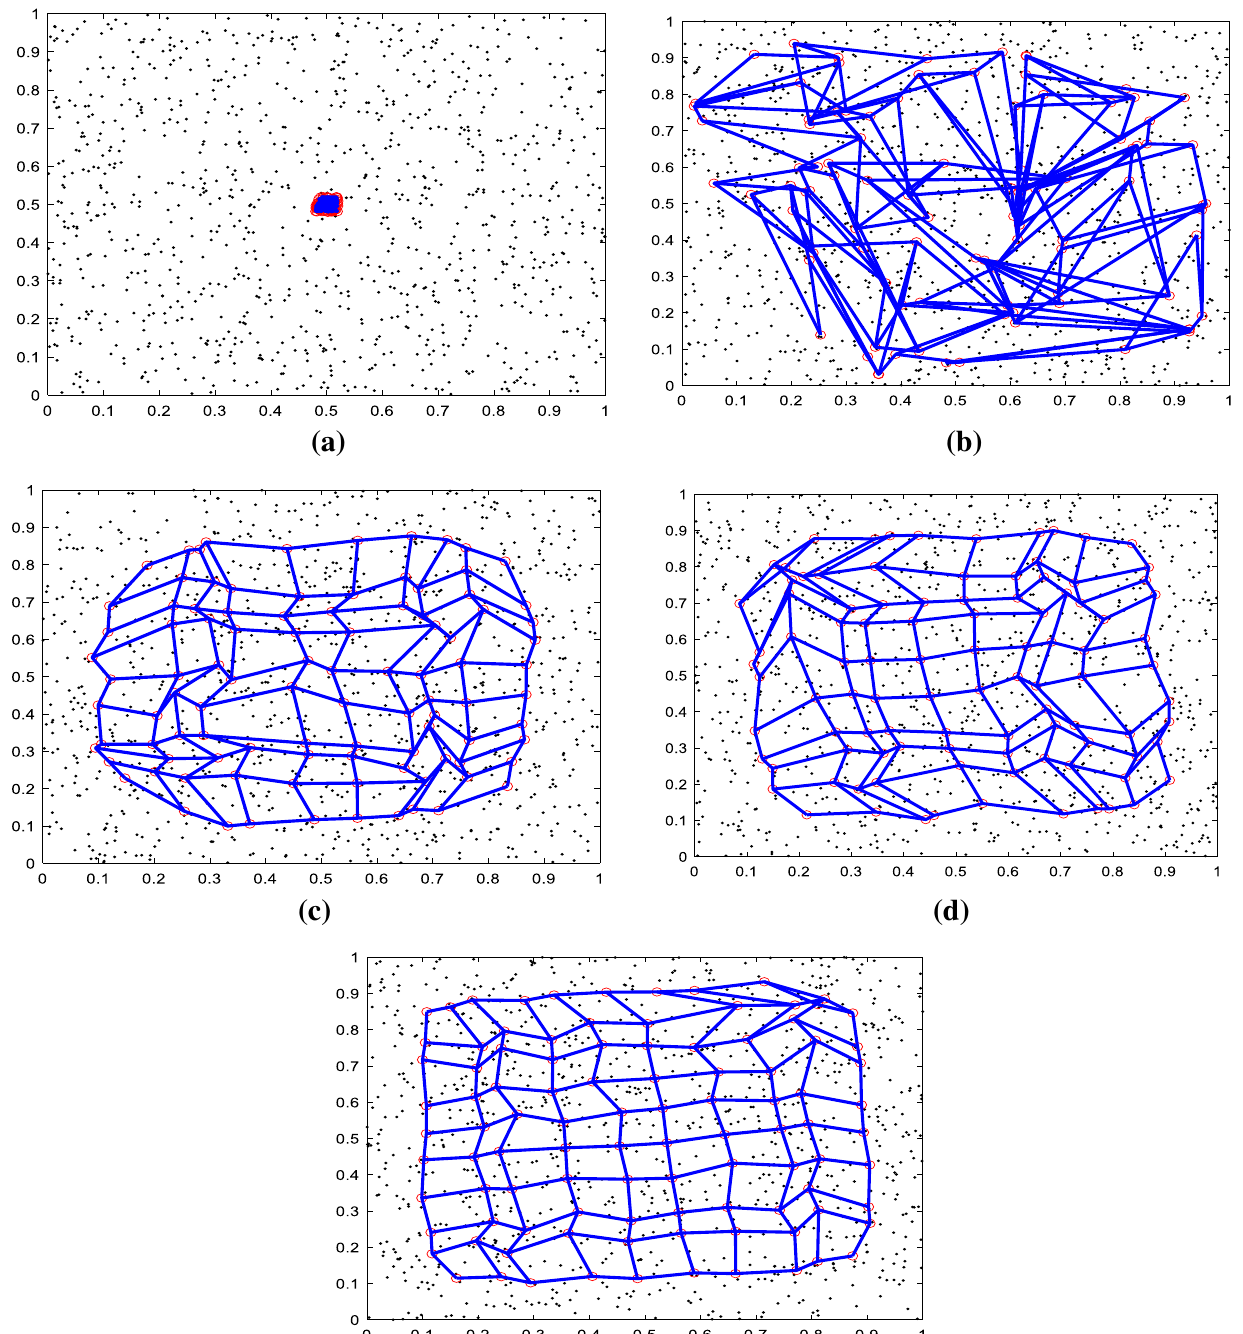
b TopologyadaptationresultsforConventionalSOM, c